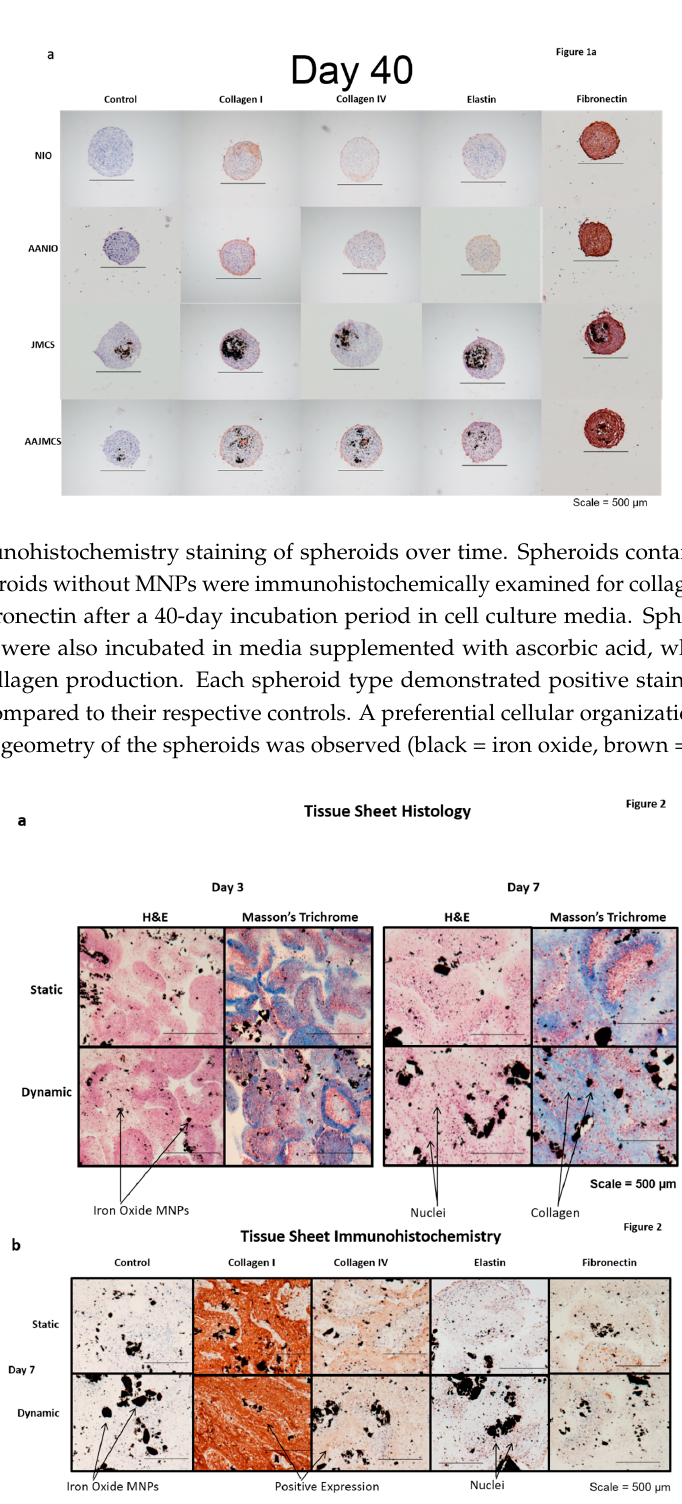
Figure 2. Tissue sheet histology. ( a ) Fused tissue sheets composed of JMCSs were either statically maintained on a magnetic template or dynamically conditioned using magnetic forces. After three and seven day time points, the sheets were collected, fixed, and processed for histological examination, with the representative H and E and Masson’s trichrome stains shown here: (black = iron oxide, blue = collagen, purple = nuclei); and ( b ) a comparison of the static and dynamic tissue sheets with the control tissue samples: all are immunopositive for collagen I, collagen IV, elastin, and fibronectin (black = iron oxide, brown = positive stain, purple = nuclei).